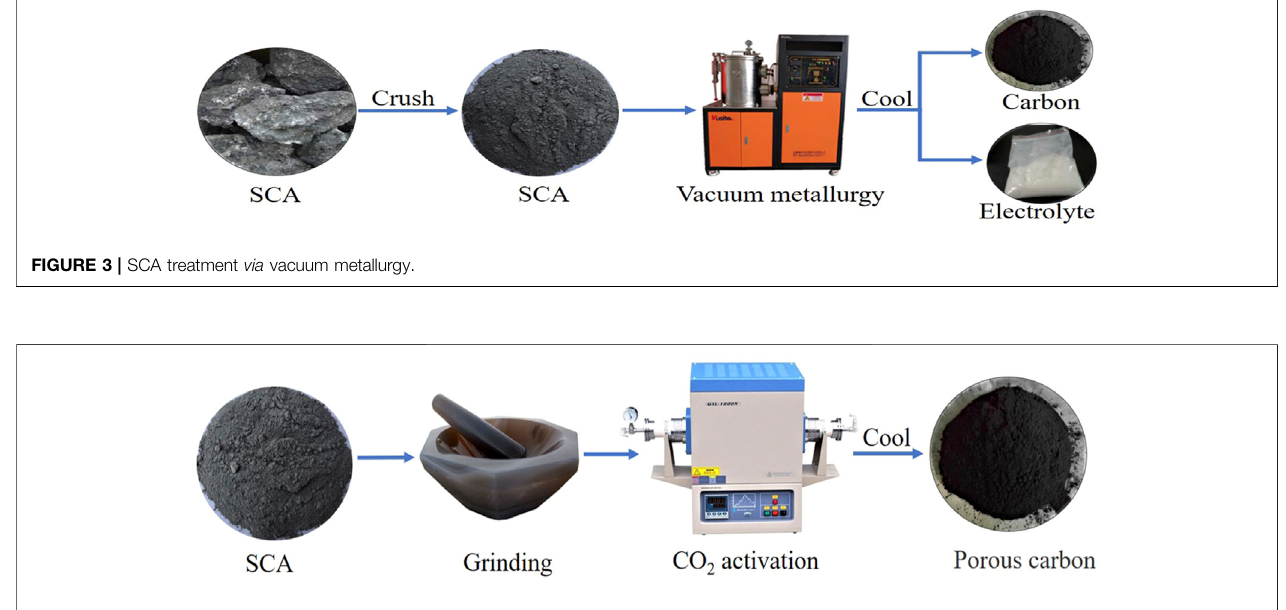
FIGURE 4 | SCA treatment via CO 2